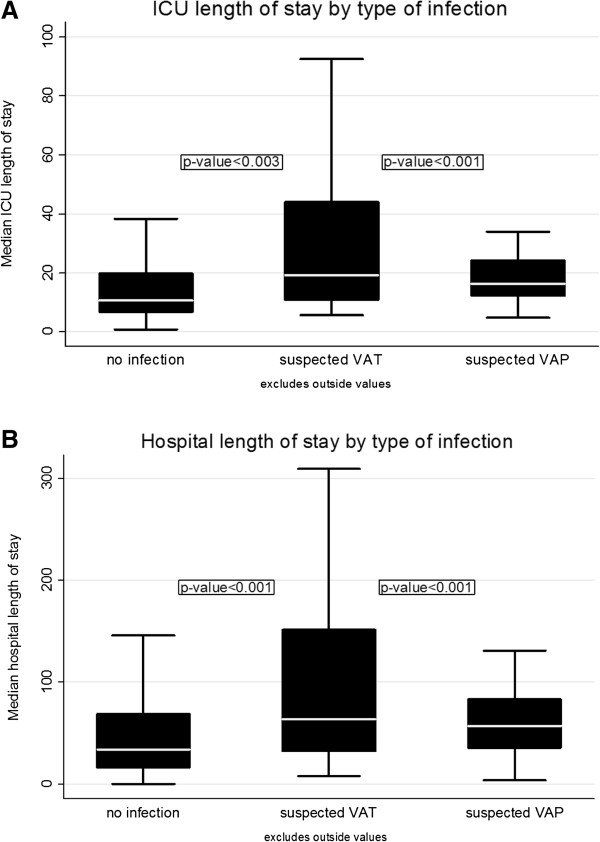
ICU or hospital length of stay in patients with sVAP or sVAT. For patients with no suspected infection, sVAT or sVAP, median values ± interquartile range (IQR) are shown for A) ICU length of stay (days) or B) hospital length of stay (days). P <0.003 for sVAT or sVAP versus no infection by Wilcoxon rank sum test. sVAP, suspected ventilator-associated pneumonia; sVAT, suspected ventilator-associated tracheobronchitis.